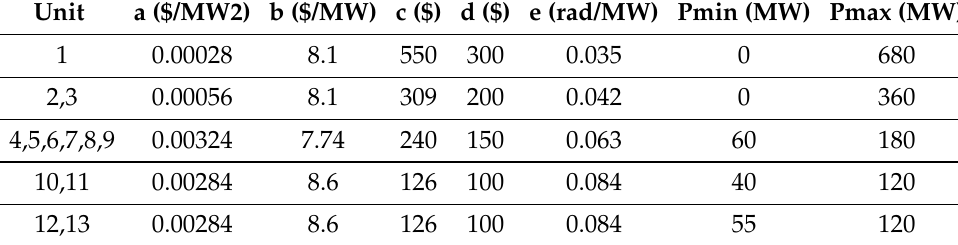
Table A10. Electrical Energy Generator unit data for Case Study